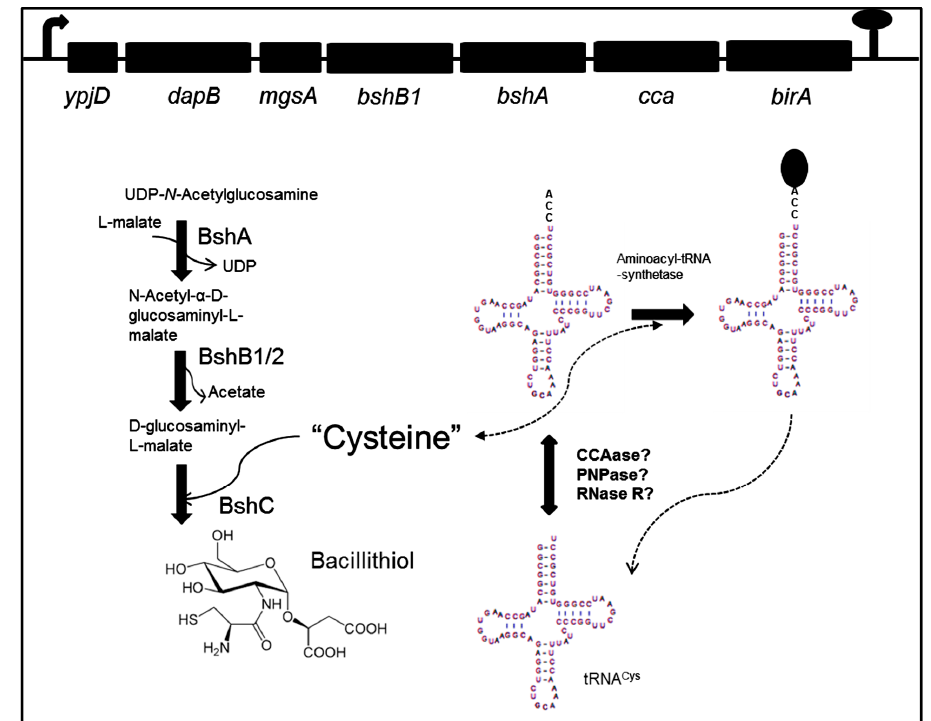
Figure 1. Possible relationship between tRNA Cys and bacillithiol biosynthesis. Genes involved in bacillithiol biosynthesis are indicated in the operon ypjD ; bshB1 ( N ‐ acetyl ‐α‐ D ‐ glucosaminyl L ‐ malate deacetylase) and bshA ( N ‐ acetyl ‐α‐ D ‐ glucosaminyl L ‐ malate synthase). The bshB2 ( N ‐ acetyl ‐α‐ D ‐